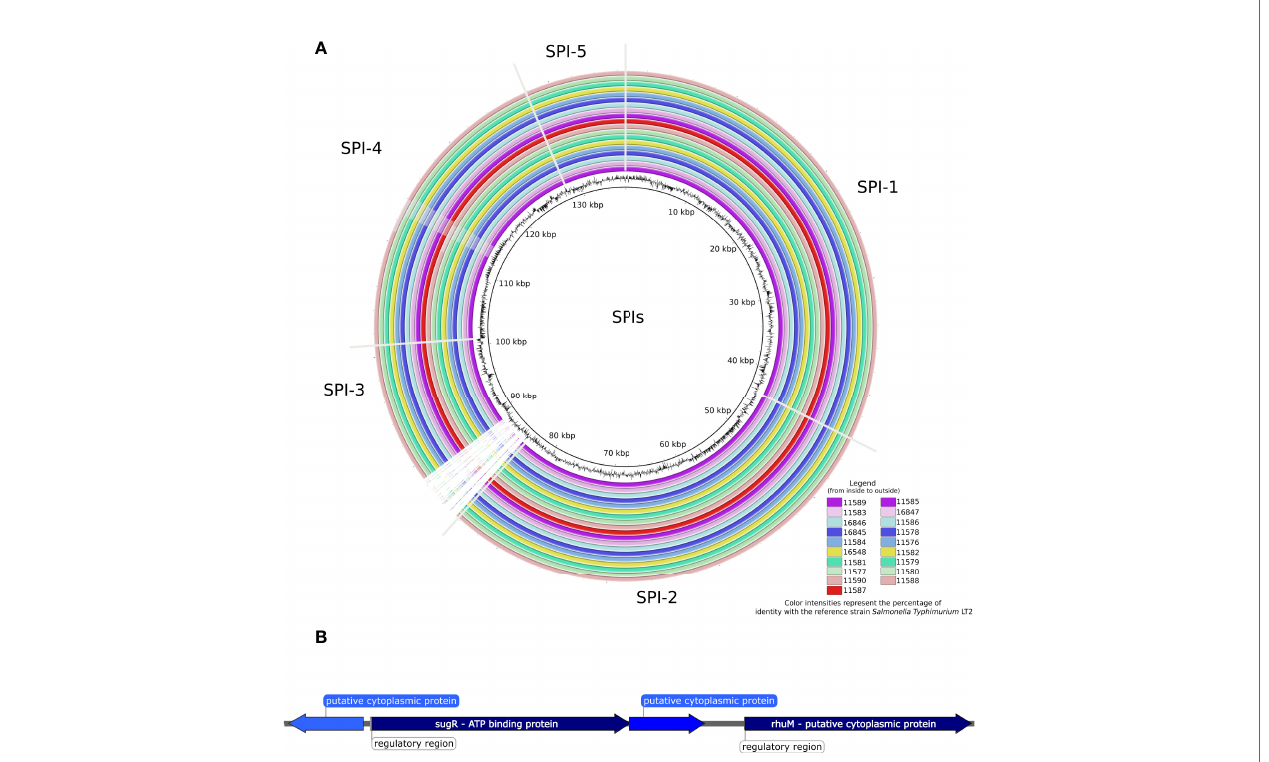
FIGURE 2 | (A) BLAST ring image of the Pathogenicity islands detected in 19 Salmonella Kentucky isolates from the African Horn region. Color intensities represent the percentage of identity (> 90%) with the reference strain Salmonella Typhimurium LT2, while blank areas indicate no identity with the reference. The fi gure is shown in order from inside to outside, starting from the isolates in the left column. (B) The ~4kb-spanning region from SPI-3 that is absent in the 19 Salmonella Kentucky